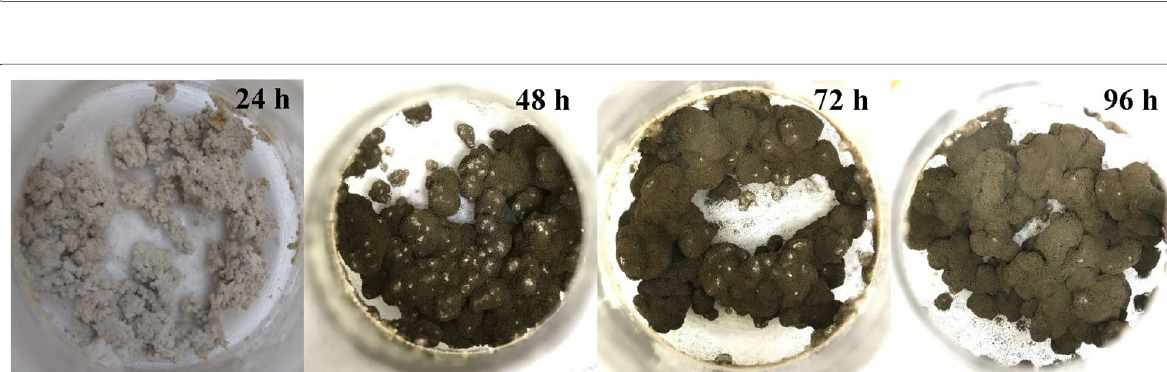
Fig. 1 SSF after 24, 48, 72 and 96 h using lentil flour as the substrate and A. oryzae LBA01 as the inoculum to obtain extracts with antioxidant and antidiabetic properties